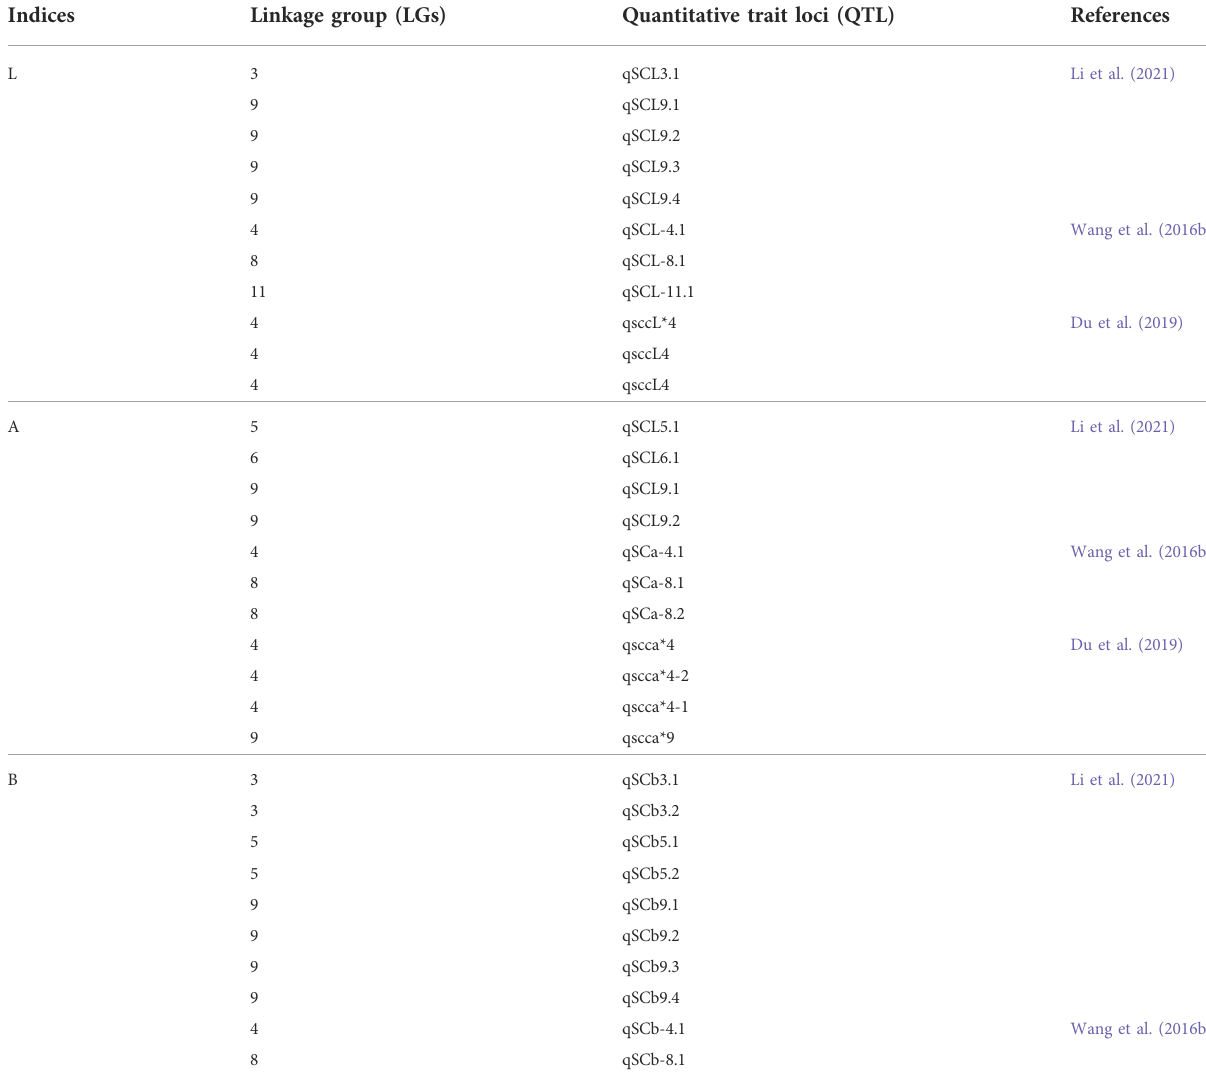
TABLE 7 Detailed information of QTLs associated with seed coat color in sesame. Indices Linkage group (LGs) Quantitative trait loci